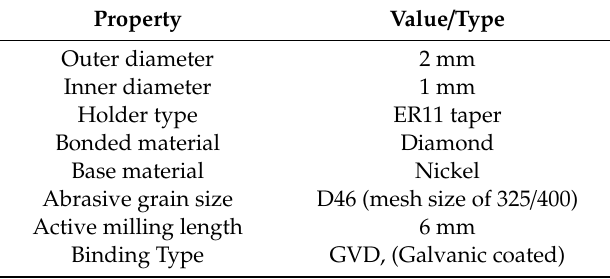
Table 2. Specifications of the RUM tool used in this study.